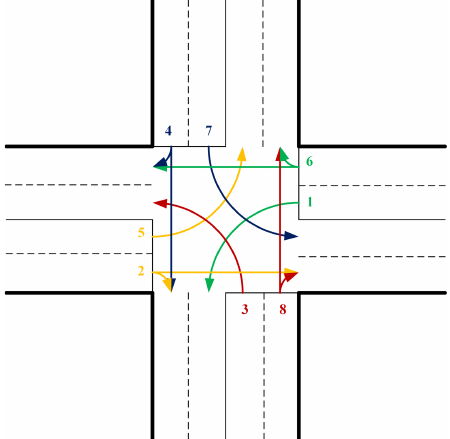
Figure 1. Combination of traffic phases at